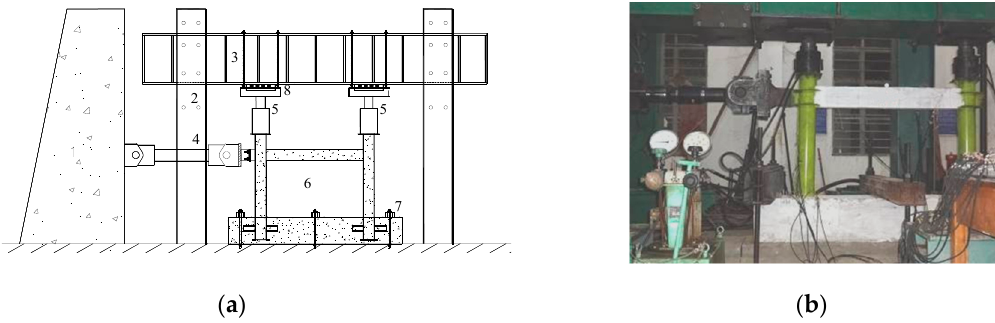
Figure 3. The test set-up arrangement of the ( a ) test device and ( b ) loading scene.